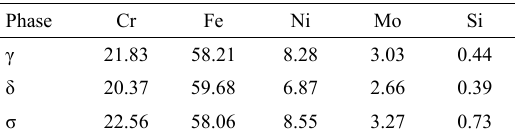
Table 4. Chemical composition of ferrite, austenite and sigma phase in the heat affected